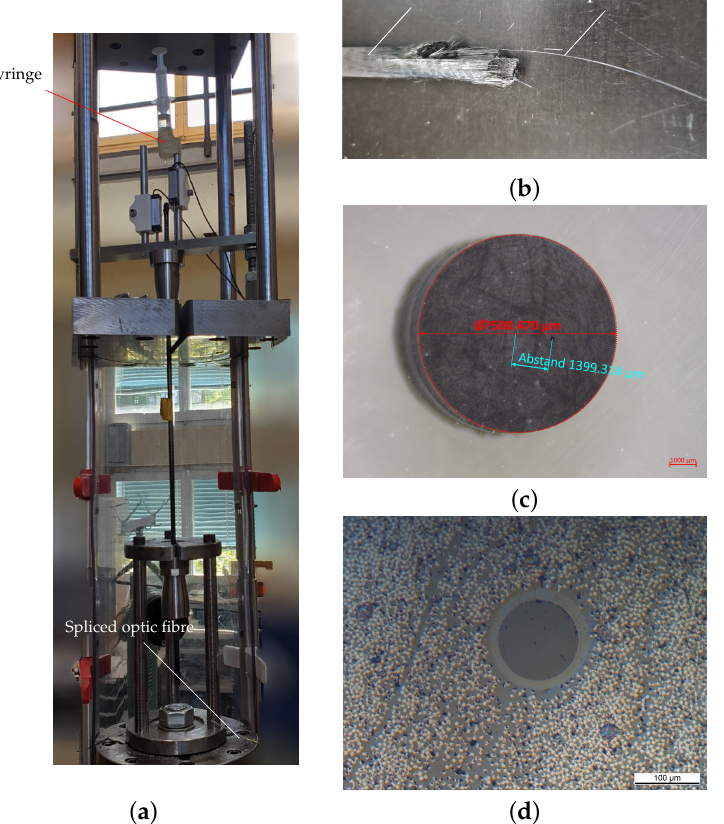
Figure 12. Tensile testing of anchored sample The strain distribution along one test sample with a total length of 0.6m and wedge 263 anchors at both ends is shown in Figure 13. In general, the strain distribution curves have 264 relatively good quality, which is due to the integration of the DFOS into the tendon. Corre- 265 lation losses are not significant. In addition, the strain in the free length is constant. Also 266 the left anchor and the right one show similar patterns. The different curves correspond to 267 different load levels. The zero measurement was taken before pressing in the wedge into 268 the barrel. The strain after setting the wedge is in the range of 2000 µ m . This stretching is 269 caused by the radial pressure, which acts on the tendon. The anchorage length increases 270 with increasing load. Above 40kN, the strain gradient is almost constant. This correlates 271 also with the measured wedge slip of two samples in Figure 14a, where wedge slip is 272 starting between 30kN and 40kN. At higher loads, not only the strain is increasing but also 273 the stress concentration, due to the additional radial pressure caused by the wedge slip. By 274 normalizing the strain distribution with the strain in the free length, a stress concentration 275